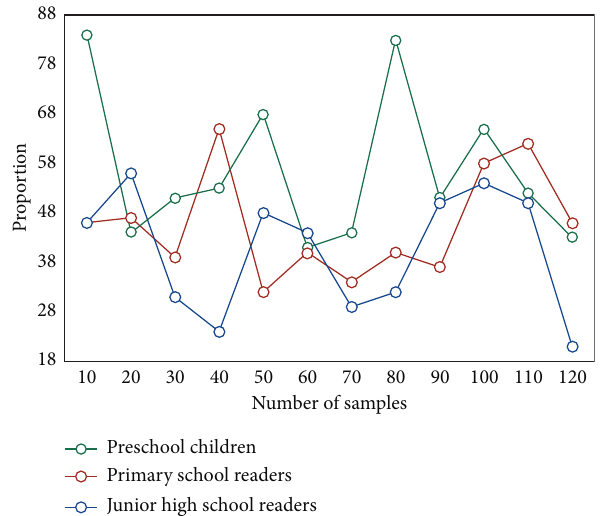
Figure 3: Proportion diagram of multimodal networked reading materials.